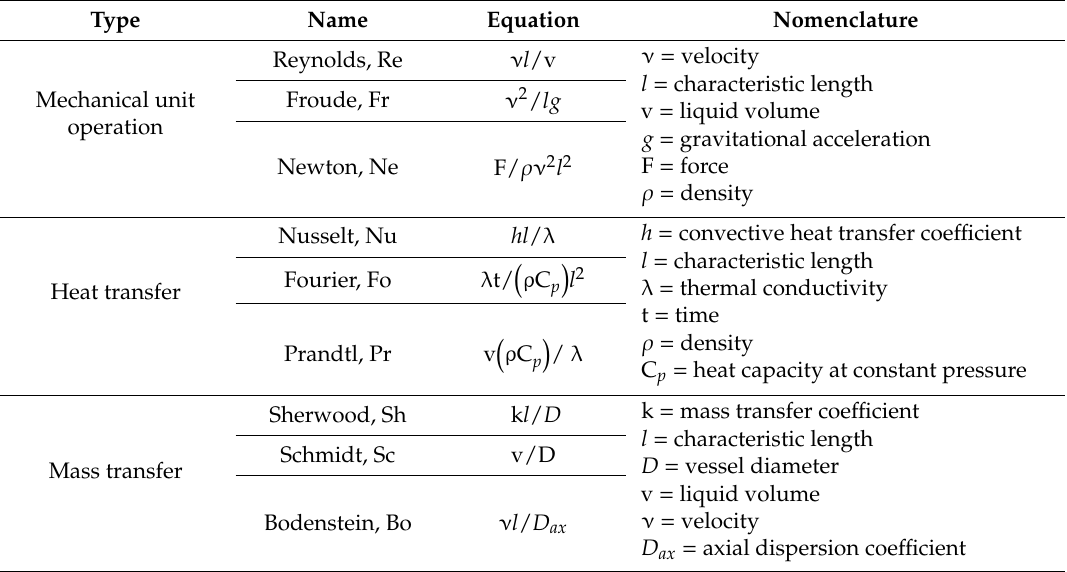
Table 1. Commonly used dimensionless numbers related to machine operation, heat transfer and mass